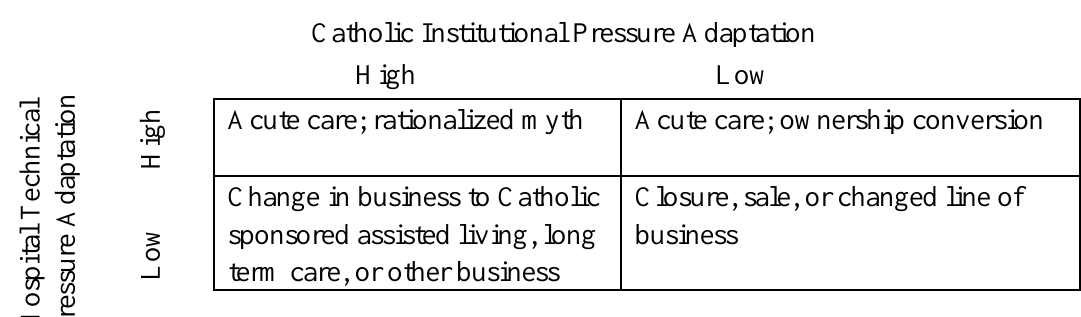
Figure 2. Adaptive